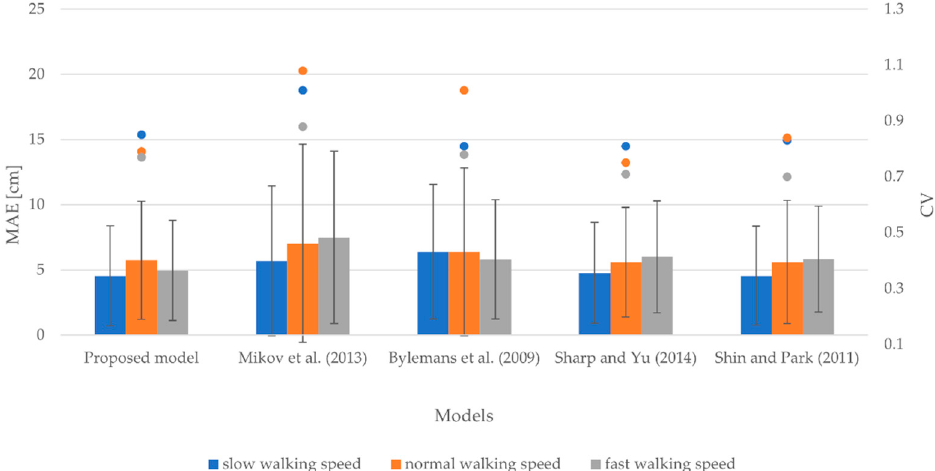
Figure 5. MAEs, SDs, and CVs for slow, normal, and fast walking speeds considering the smartphone attached to the pelvis.